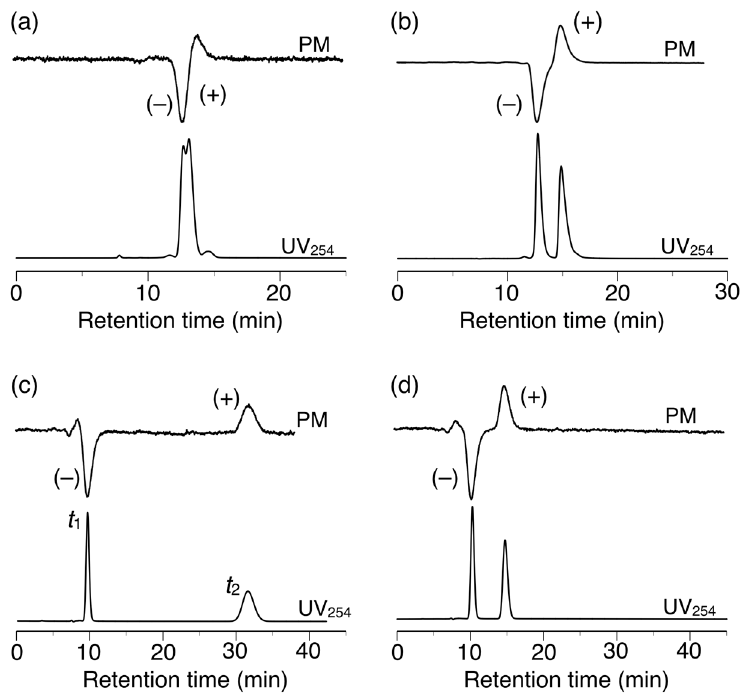
Figure 7. HPLC chromatograms for the resolution of 15 ( a , b ) and 16 ( c , d ) on poly- 2 S ( a , c ) and h -poly- 2 S ( b , d ). Eluent: hexane–2-propanol (99:1, v / v ) ( a , b ), MeOH–H 2 O (90:10, v / v ). h -Poly-( 2 S 0.36 - co - 3 0.64 ) exhibited different chiral recognition properties to h -poly- 2 S and successfully